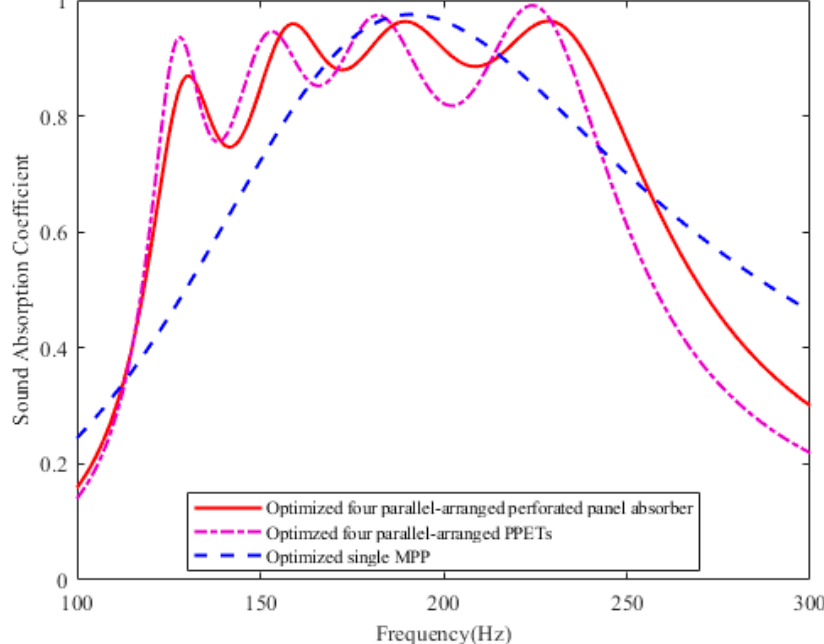
Figure 3. Comparison of the sound absorption of the four parallel-arranged PPAs and PPETs, MPP absorber in the frequency range of 120–250 Hz.